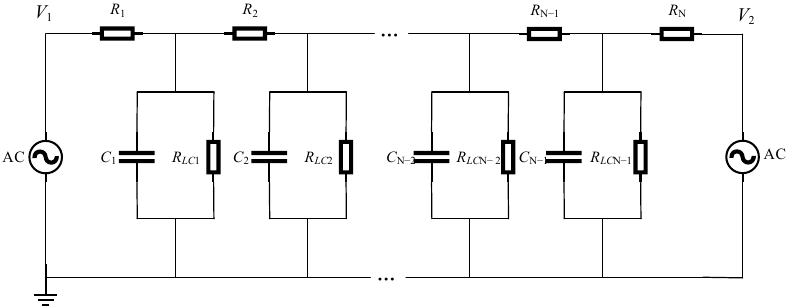
Figure 5. The equivalent circuit of an LC lens based on the electrode pattern in Figure 4a. The resistance of the concentric ITO line is